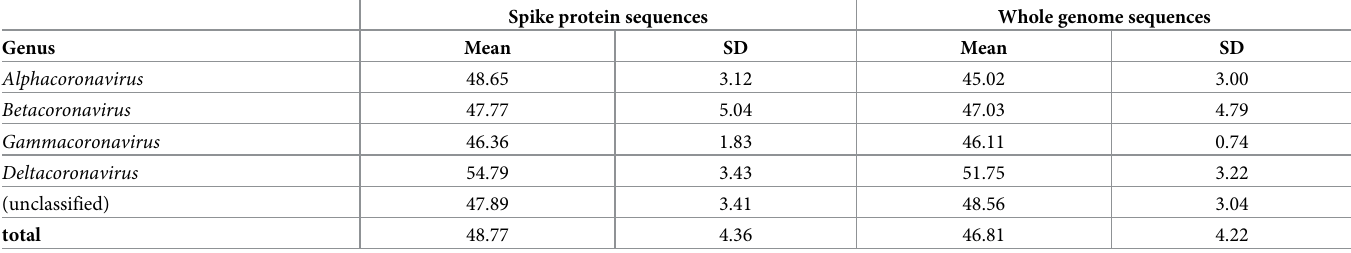
Table 1. ENc values across coronavirus genera. Effective Number of Codons (ENc) for coronaviruses, stratified by genus and genome sequence type. ENc values are cal- culated as grand means, i.e., mean ENc was calculated per coronavirus by averaging sequences before means of means were calculated per genus by averaging coronavi- ruses. SD denotes standard